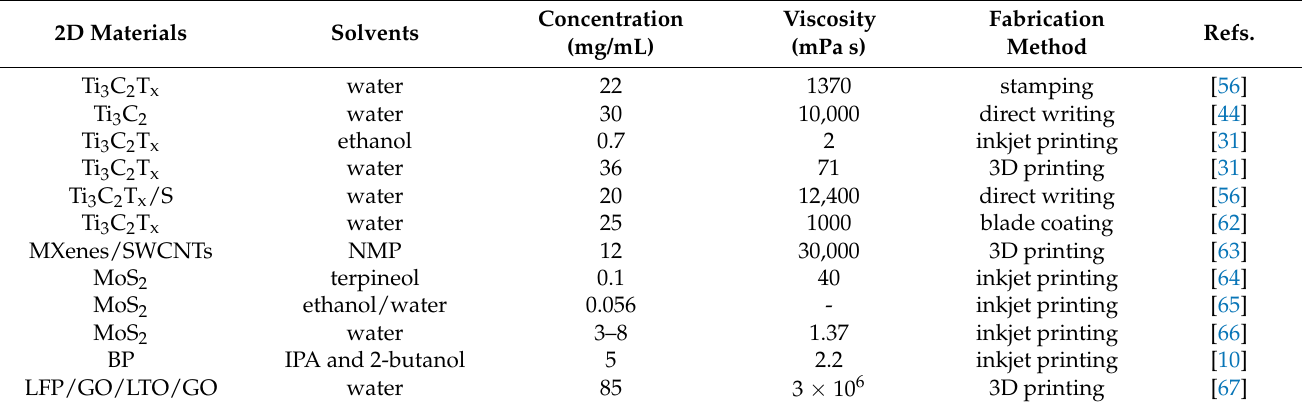
Table 1. Summary of the some reported 2D materials inks for numerous printing